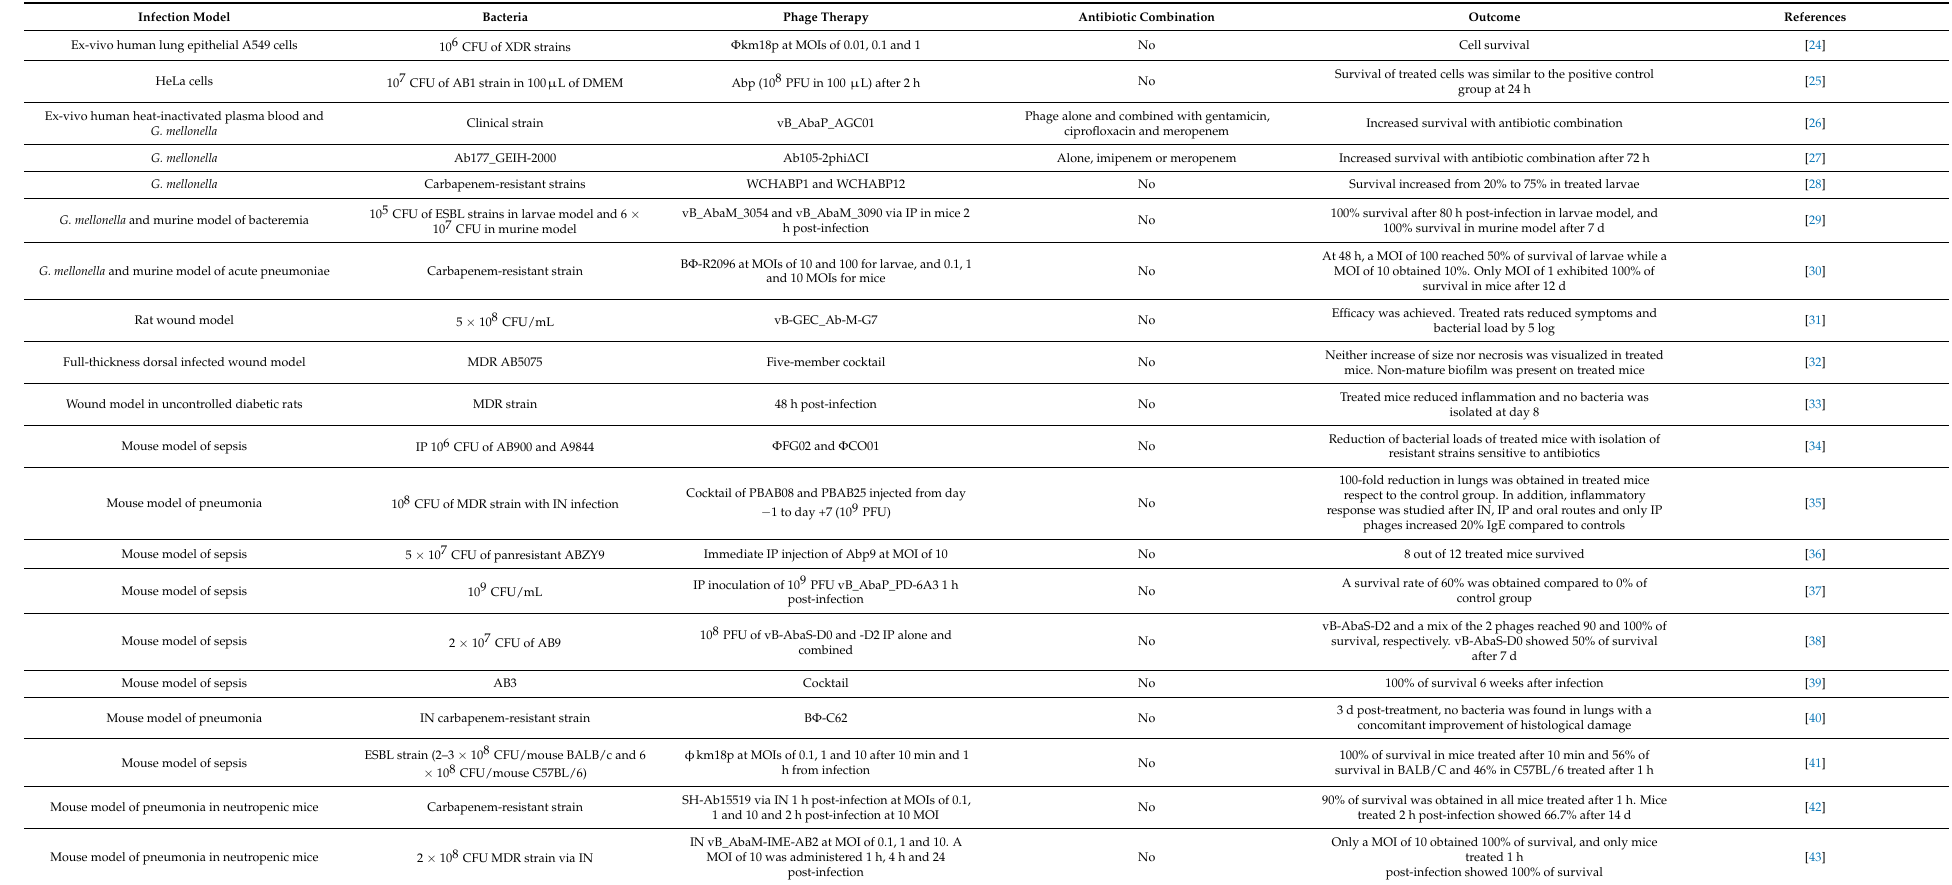
Table 1. Summary of in vivo studies using phage therapy against A. baumannii